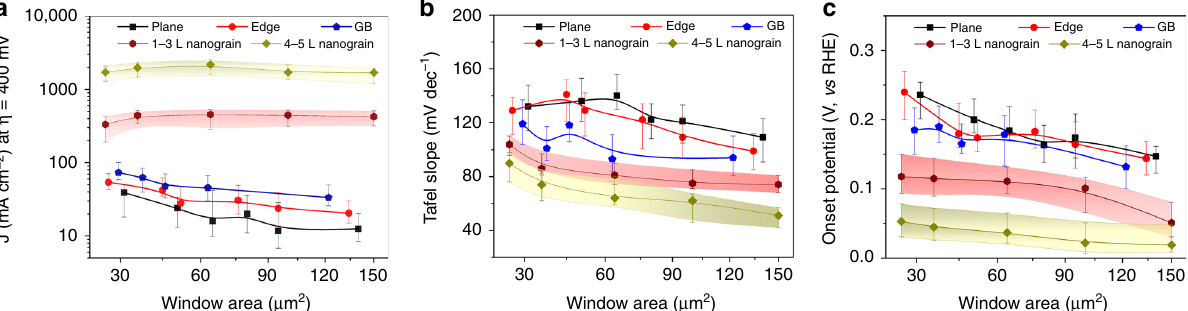
Fig. 6 Comparison of the HER performances in a size-controlled micro-electrochemical cell. a – c Current density ( a ), Tafel plots ( b ), and onset potentials ( c ) for the MoS 2 devices with serial window sizes from 25 – 150 μ m 2 . The nanograin fi lms show higher current density, lower Tafel slope, and onset potential compared to the basal plane, single edge, and